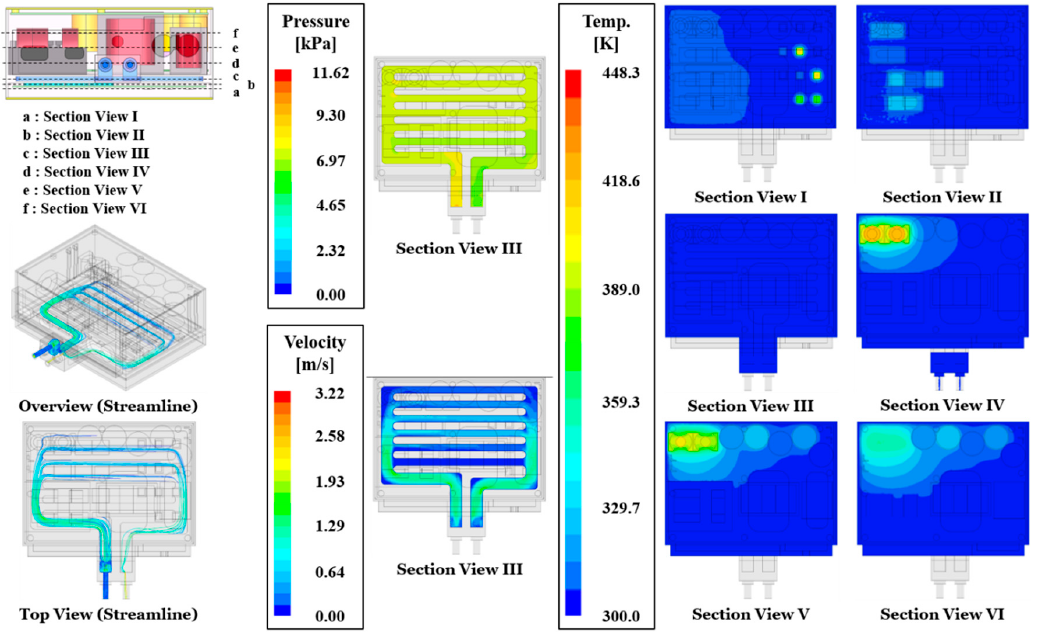
Figure 8. Streamline, pressure, velocity, and temperature distribution in the integrated module with a cooling water flow rate of 6 LPM over a 4000 s time span in Operating Mode 1.